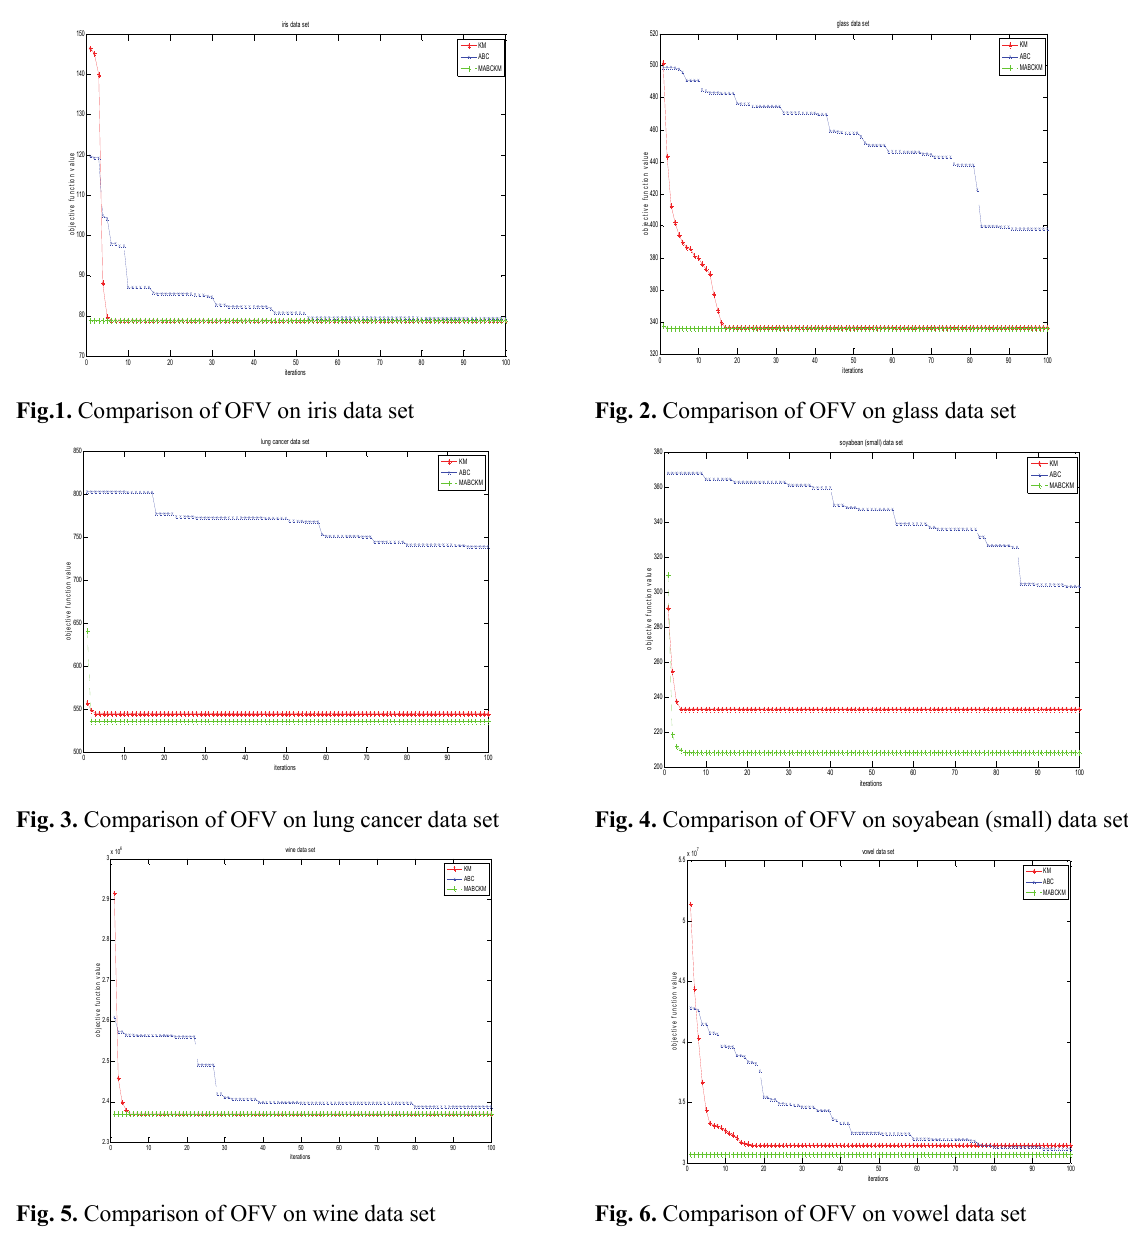
Fig. 5. Comparison of OFV on wine data set Fig. 6. Comparison of OFV on vowel data